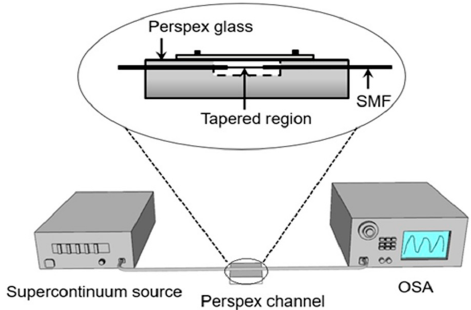
Figure 4. Experimental set-up for ammonia nitrogen measurement.